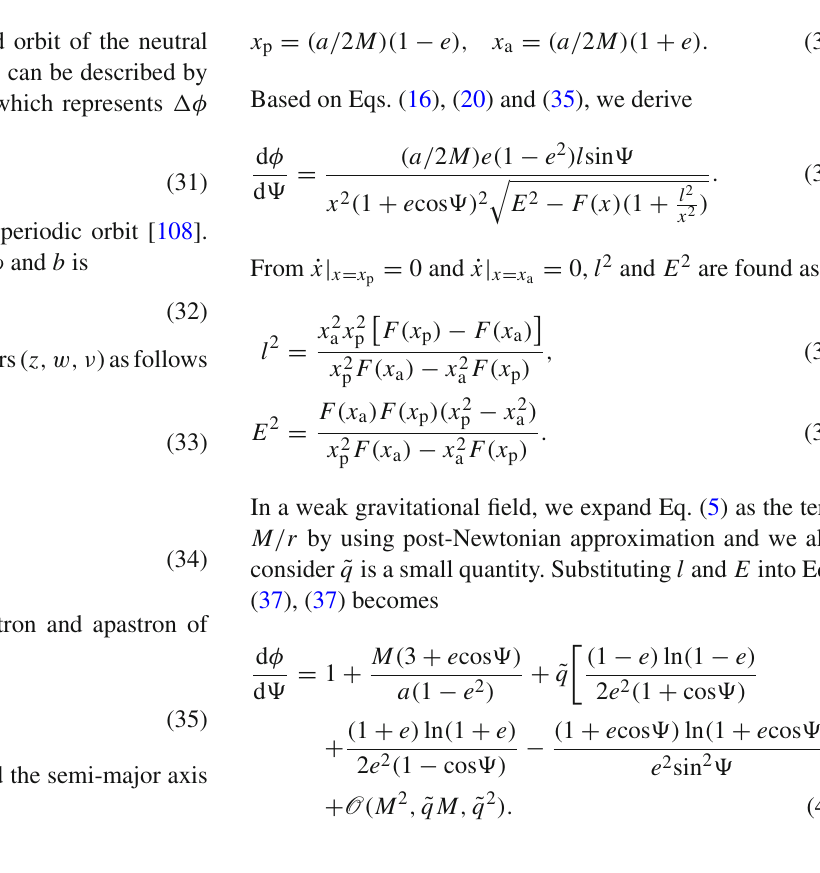
that the regions with the blue and red ones in the third row are almost the same one because the values of ˜ q = 0 and ˜ q = − 8 . 2 × 10 − 5 are very